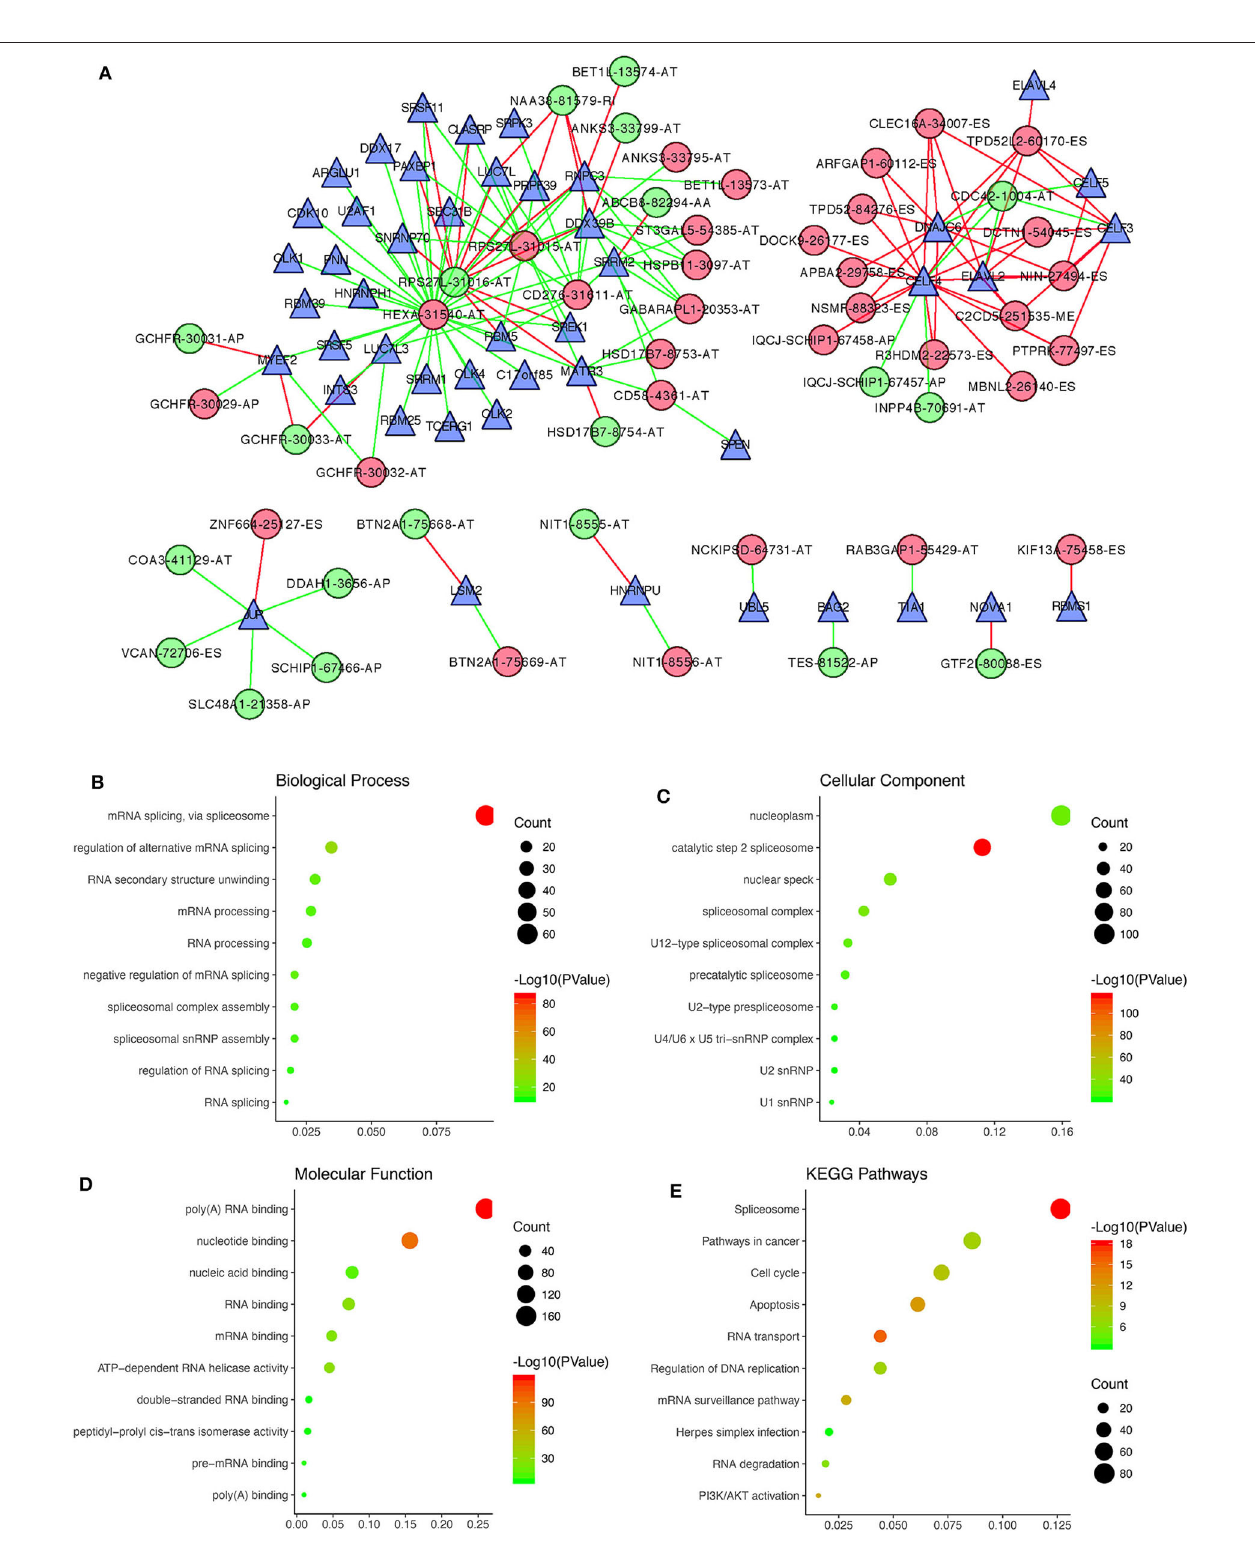
FIGURE 7 | Correlation analysis between prognostic AS events and SFs. (A) The regulatory network between 47 survival-associated SFs and 52 survival-associated AS events, with |Pearson correlation coefficient| > 0.6 and P < 0.001. Green and red dots, respectively, represent favorable and unfavorable prognostic AS events. Green and red lines, respectively, represent negative and positive correlations between AS events and SFs. Blue triangles represent SFs. (B–E) Functional enrichment analysis of the 392 SF genes having |Pearson correlation coefficient| > 0.4 with prognostic AS events.